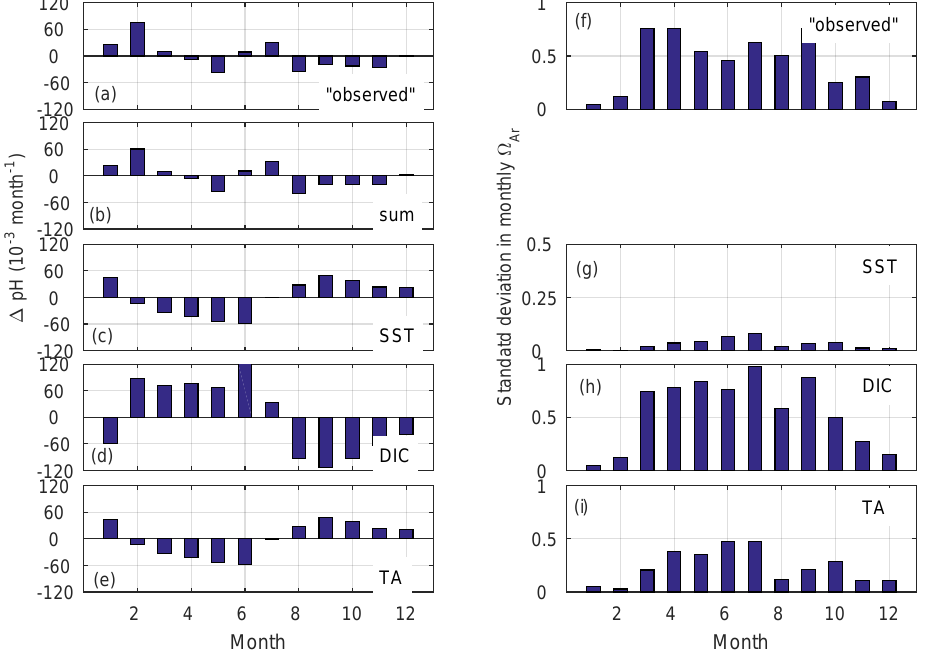
Figure 4. Left panel: monthly pH changes ( (cid:49) pH) as observed (a) and expected due to sum of all derivers (b) , SST changes (c) , DIC changes (d) , and by TA changes (e) . Right panel: standard deviations in monthly mean (cid:127) Ar as a result of variations in all parameters (f) or only in SST (g) in DIC (h) in TA (i)